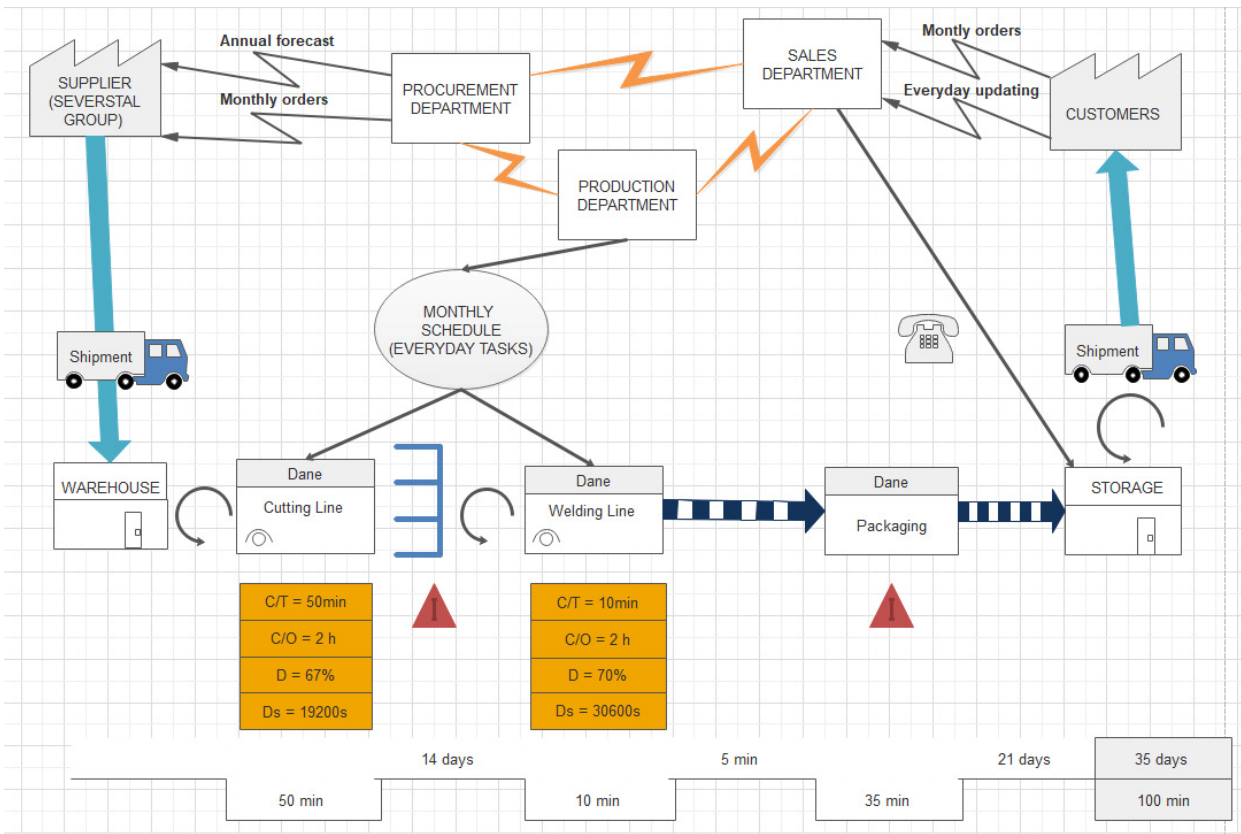
Figure 4. Legend of the map.